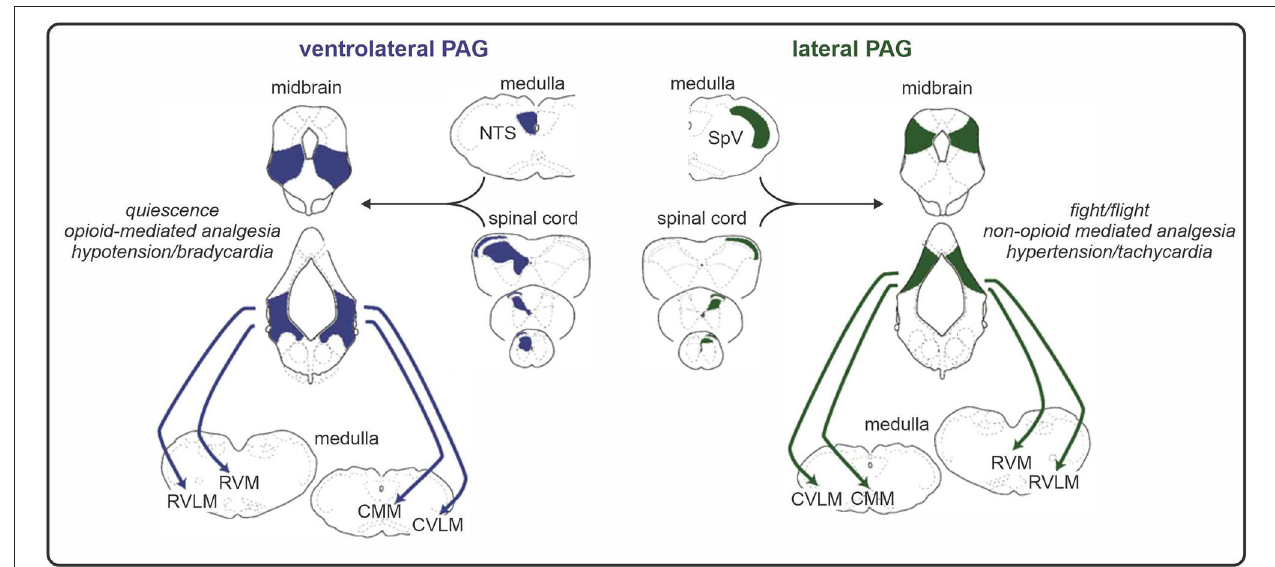
FIGURE 2 | Functional and anatomical organisation of the midbrain periaqueductal grey (PAG). The ventrolateral column of the PAG receives direct input from the spinal cord dorsal horn and evokes an opioid-mediated analgesia alongside a distinct set of coping behaviours including quiescence. Conversely, the lateral PAG receives direct inputs from the dorsal horn/spinal trigeminal nucleus (SpV) that are organised in a somatotopic manner and can elicit fight or flight responses and a non-opioid mediated analgesia via its projections to medullary nuclei. RVLM, rostral ventrolateral medulla; RVM, rostral ventromedial medulla; CMM, caudal medial medulla; CVLM, caudal ventrolateral medulla; NTS, nucleus of the solitary